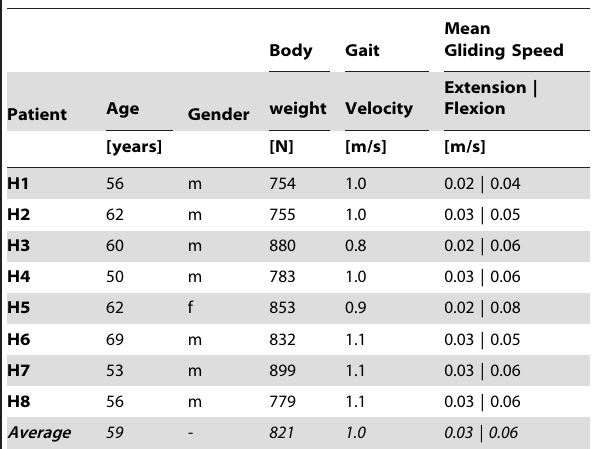
Table 1. Patients investigated.